Question: What form of chart is displayed?
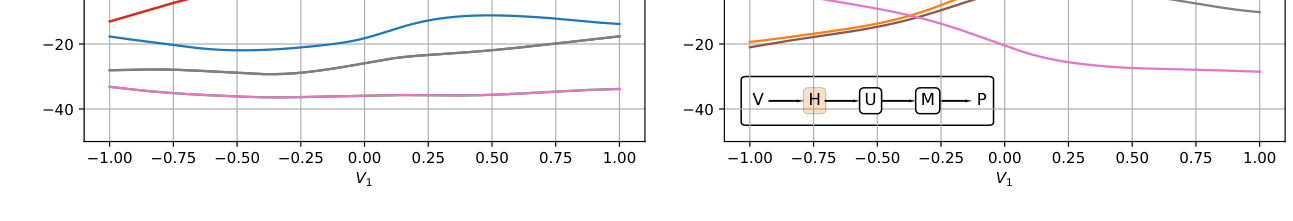
Answer: line